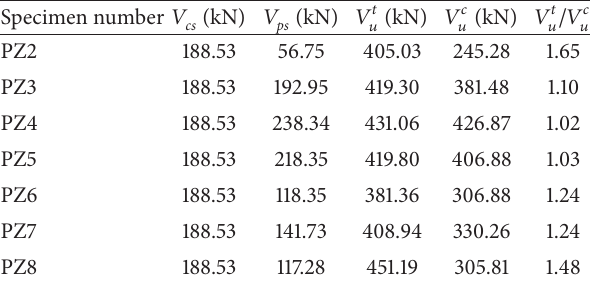
Table 3: Comparison of calculation and test